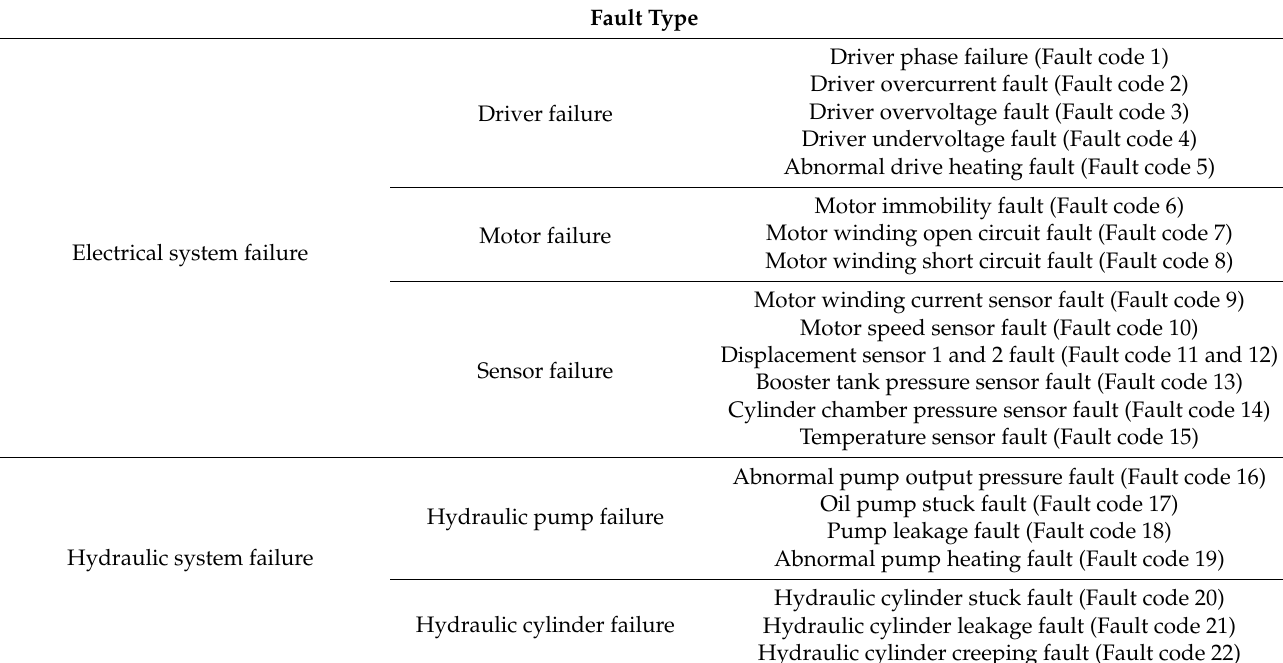
Table 2. Double redundancy EHA fault